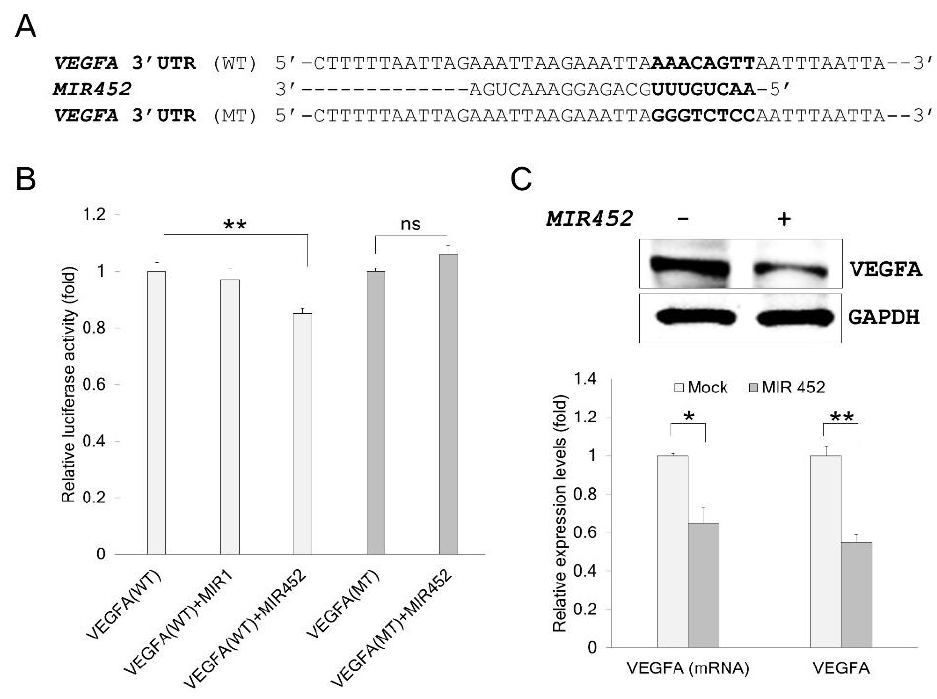
Figure 1. VEGFA was a direct target of MIR452 . ( A ) Sequence alignment of the wild type (WT)